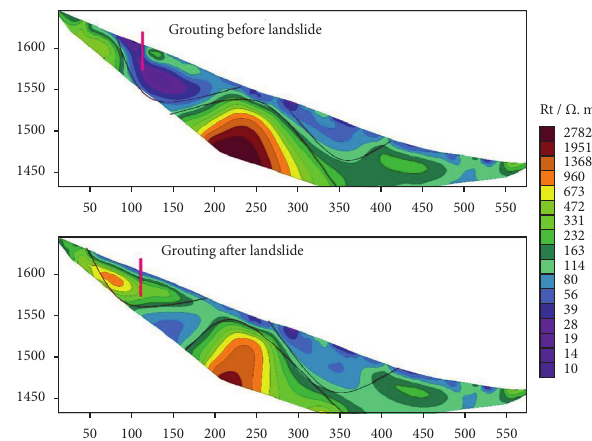
Figure 19: Experimental results of the grouting reinforcement treatment of a landslide area.